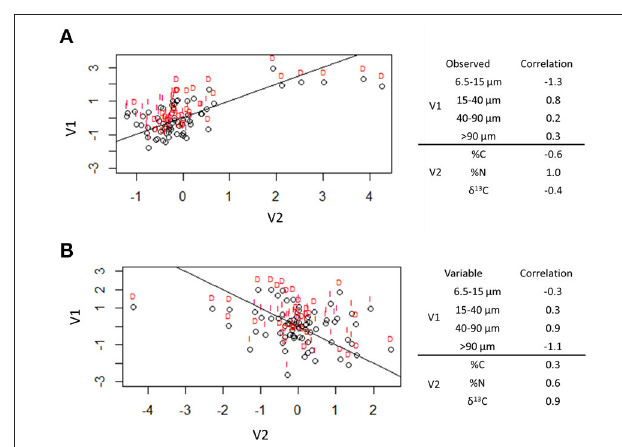
FIGURE 7 | Canonical correlation of pore sizes with total C (%C), total N (%N), and δ 13 C. The first two canonical correlations were significant at α = 0.05 and are shown. The correlation factors that define the latent variables for each axes are shown on the right. The sign indicates the direction of correlation and the number indicates the amount each observed variable contributes to the latent variable. Lines indicate the (0, 1) line (A) and (0, − 1) line (B) , while letters indicate treatment [destroyed-structure (D) and intact-structure